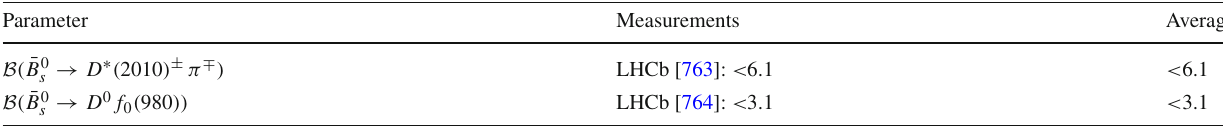
Table 189 Decays to a D ( ∗ ) and a light meson II [ 10 − 6 ]